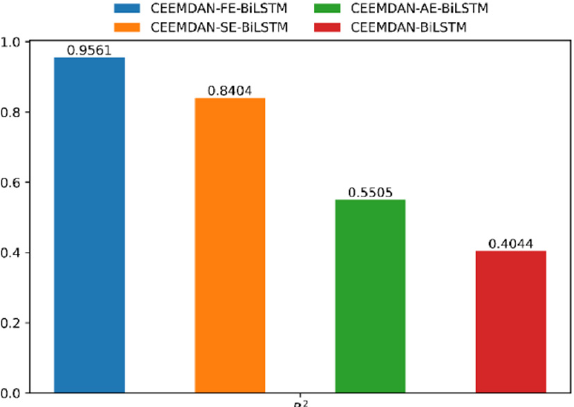
Figure 11. Comparison of the goodness of fit of the O 3 concentration prediction model.